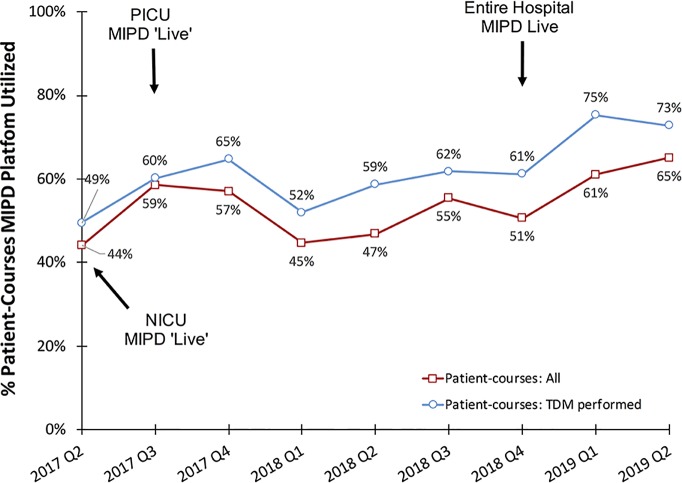
Percentage of vancomycin patient-courses utilizing the MIPD CDS tool by quarter. “Patient-courses: All” are courses of vancomycin where at least one dose was given. “Patient-courses: TDM performed” are courses of vancomycin where at least one therapeutic drug monitoring concentration was measured.